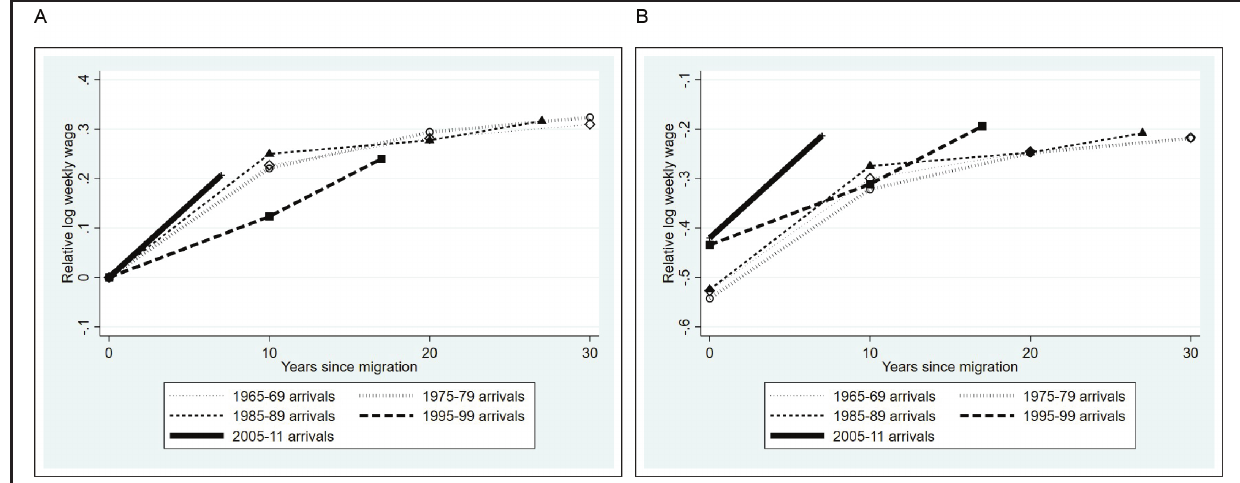
Figure A1 Age-adjusted convergences for the relative weekly earnings of Mexican and Central American immigrant cohorts, only high school educated or less: (A) normalized convergence; (B) initial gap and